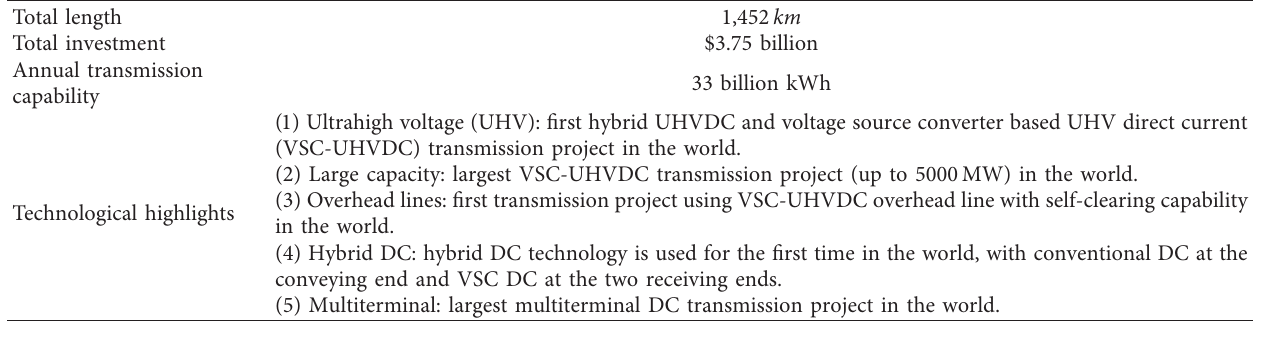
Table 3: Basic information of Kunliulong DC